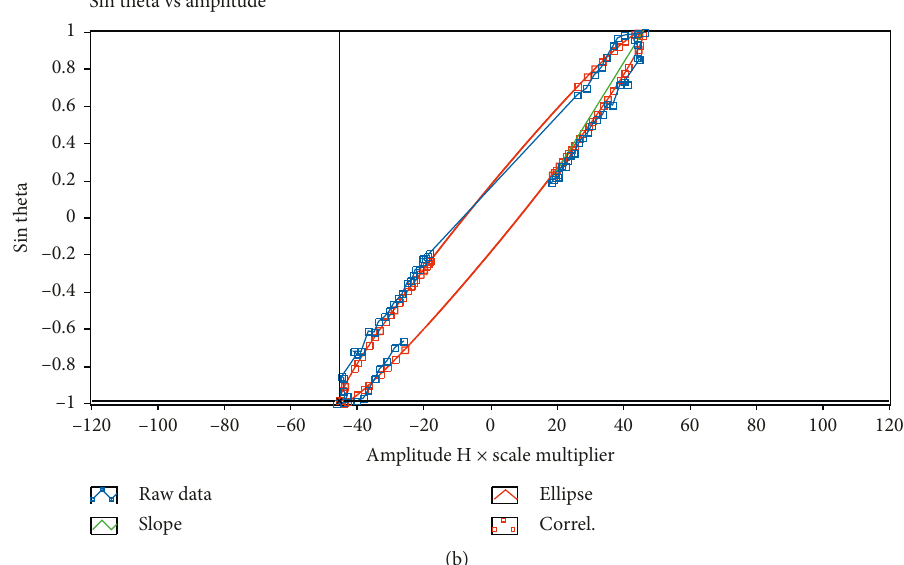
Figure 7: Ellipse area for plate A1: (a) healthy; (b) damaged.